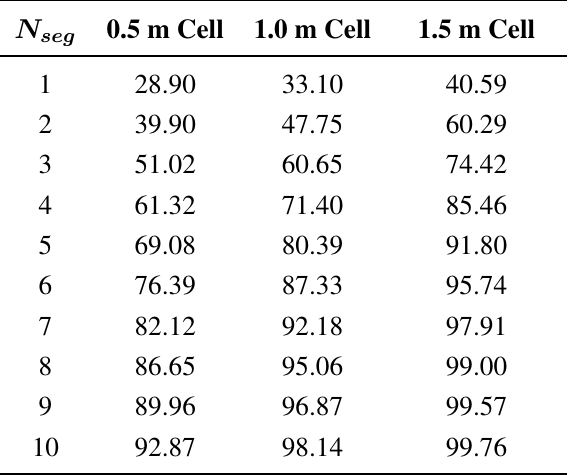
Table 6. Location estimation performance with different N simulations, estimation error smaller than 1m is considered as